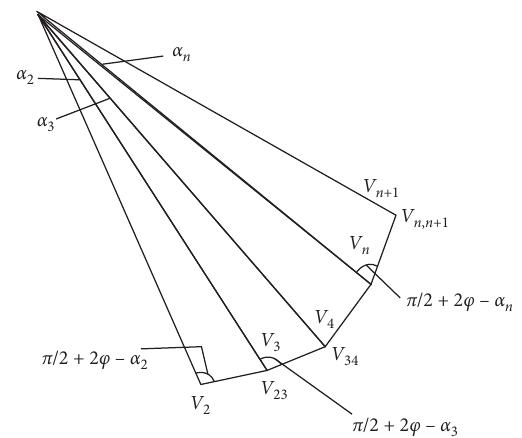
Figure 4: Exploded view of the velocity